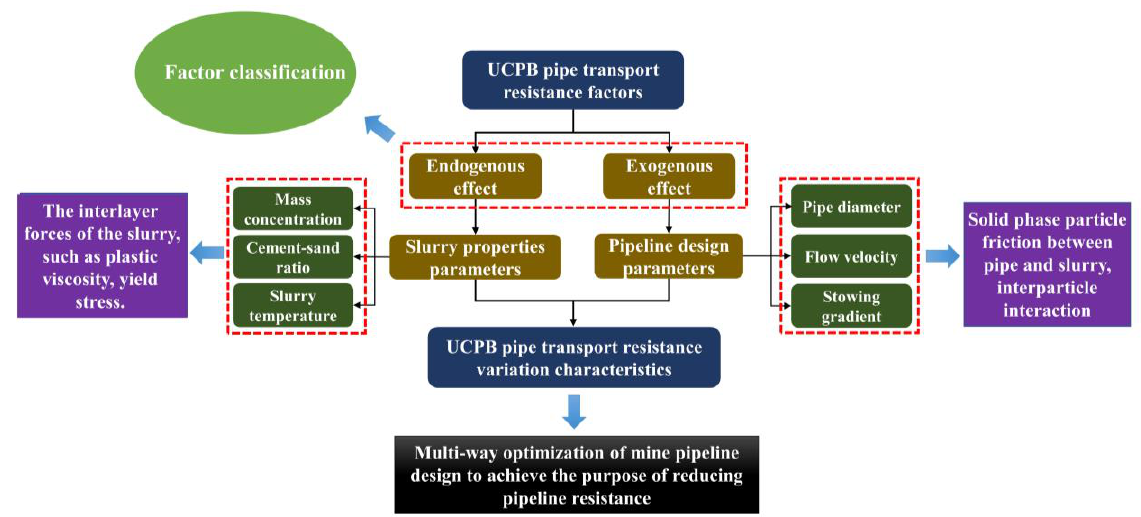
Figure 2. Classification and integration of factors affecting pipeline resistance.